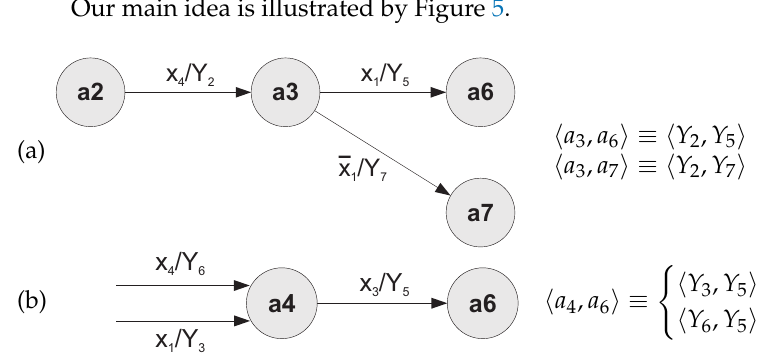
by pairs a m , a s (cid:104) (cid:105)